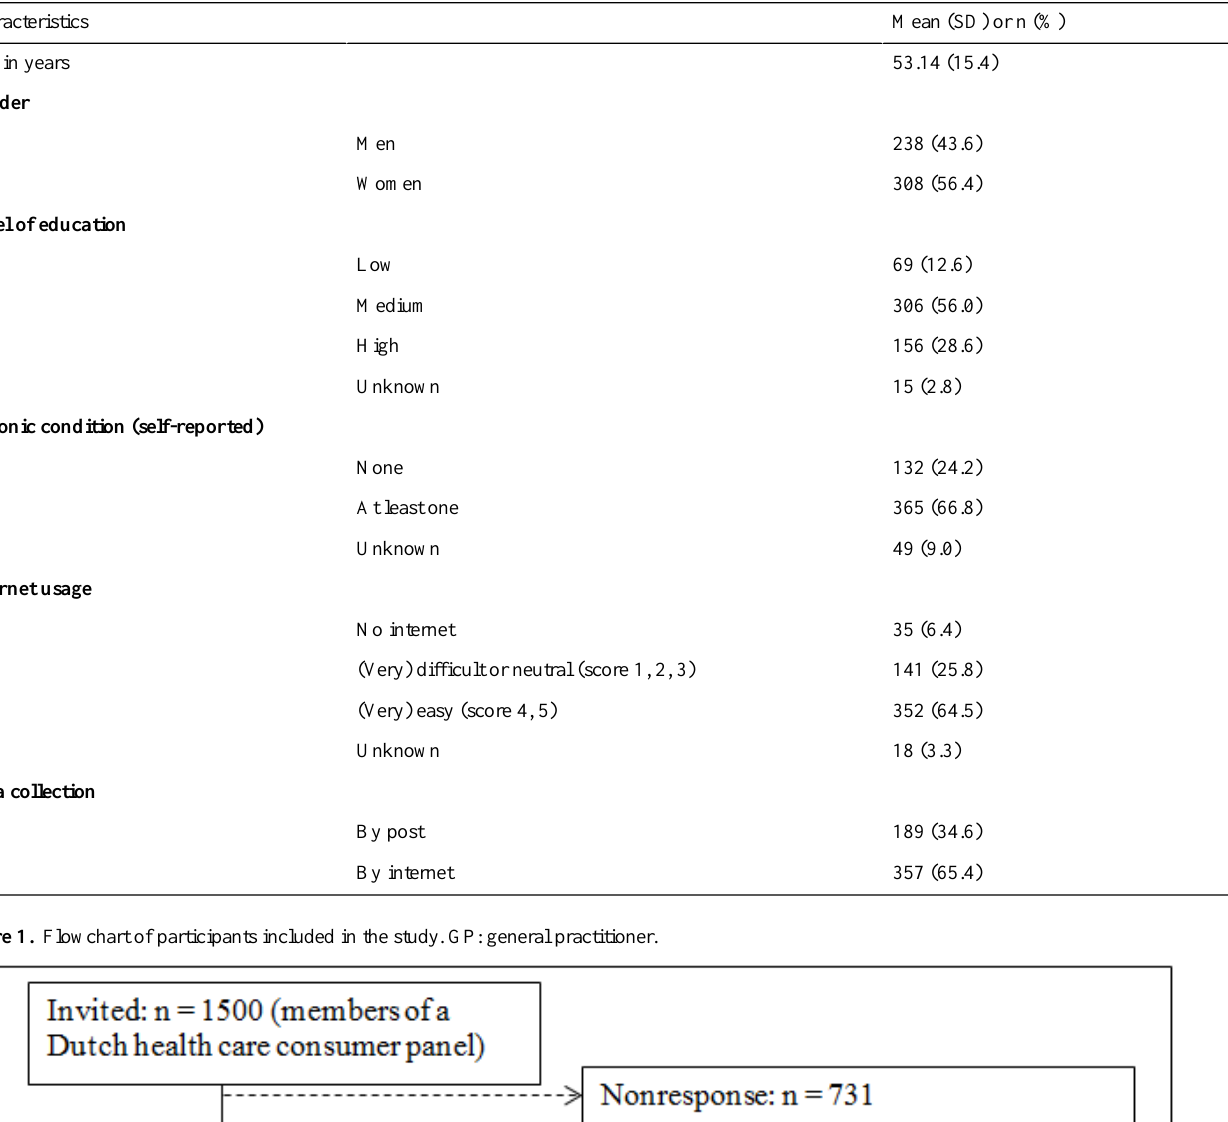
Table 1. Characteristics of the study sample (n=546).